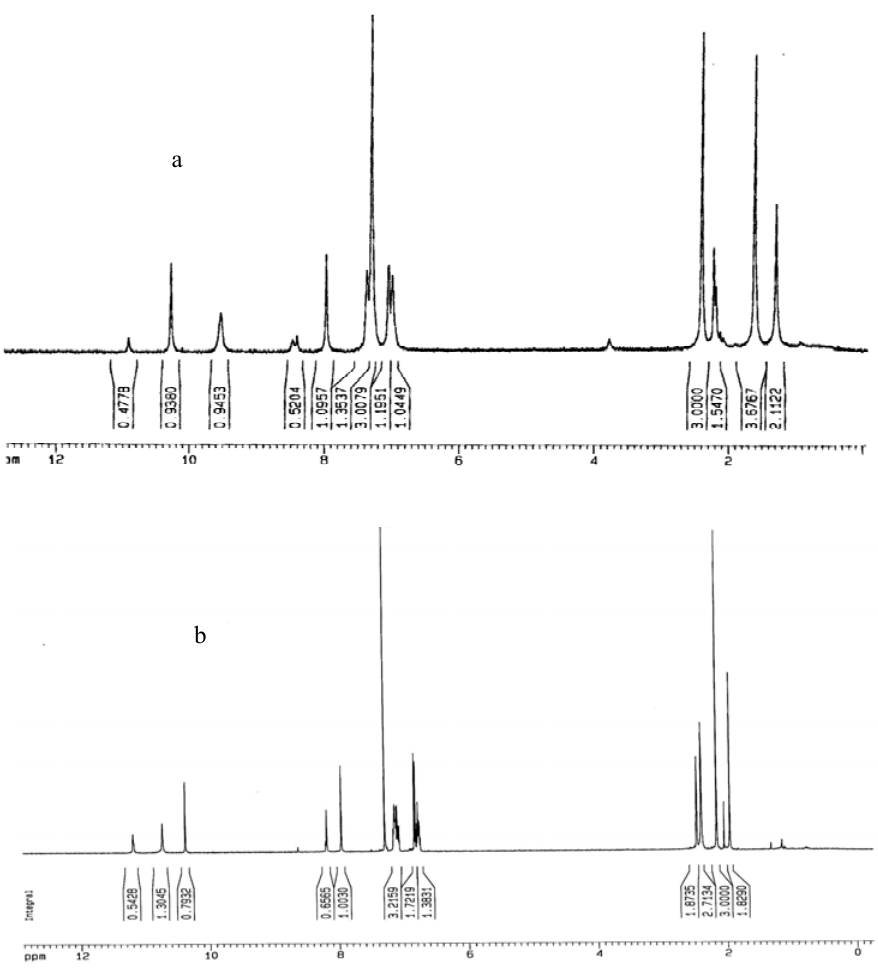
Figure 2. H-NMR spectra of (a) C